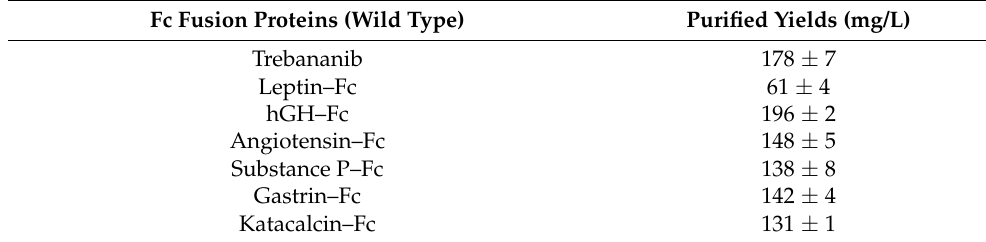
Table 1. Yields of wild type Fc fusion proteins purified from 3 mL cultures (24